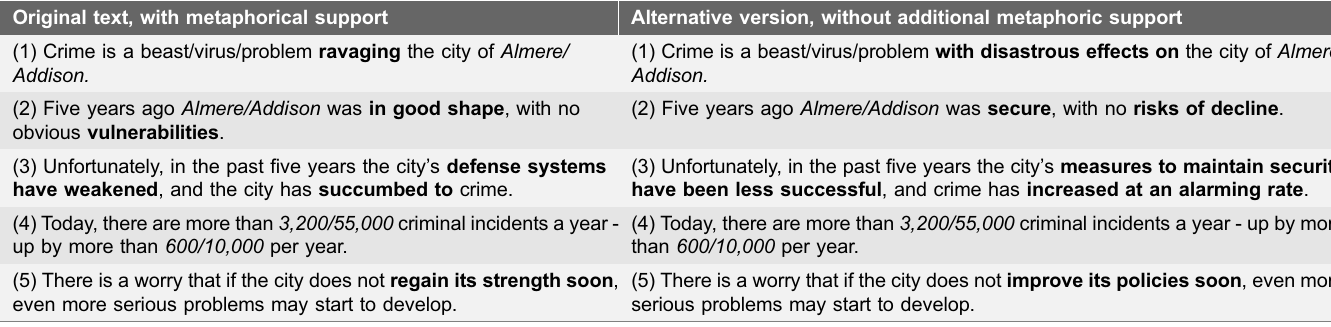
Table 1. Metaphorically framed texts with and without additional metaphorical